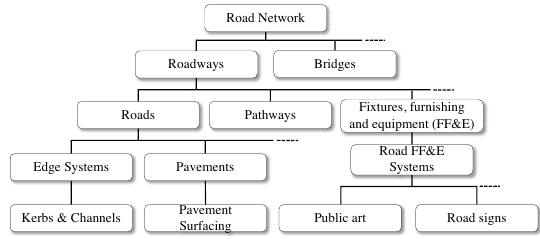
Figure 3. A sample LBS for the road network (Gelder, 2018).